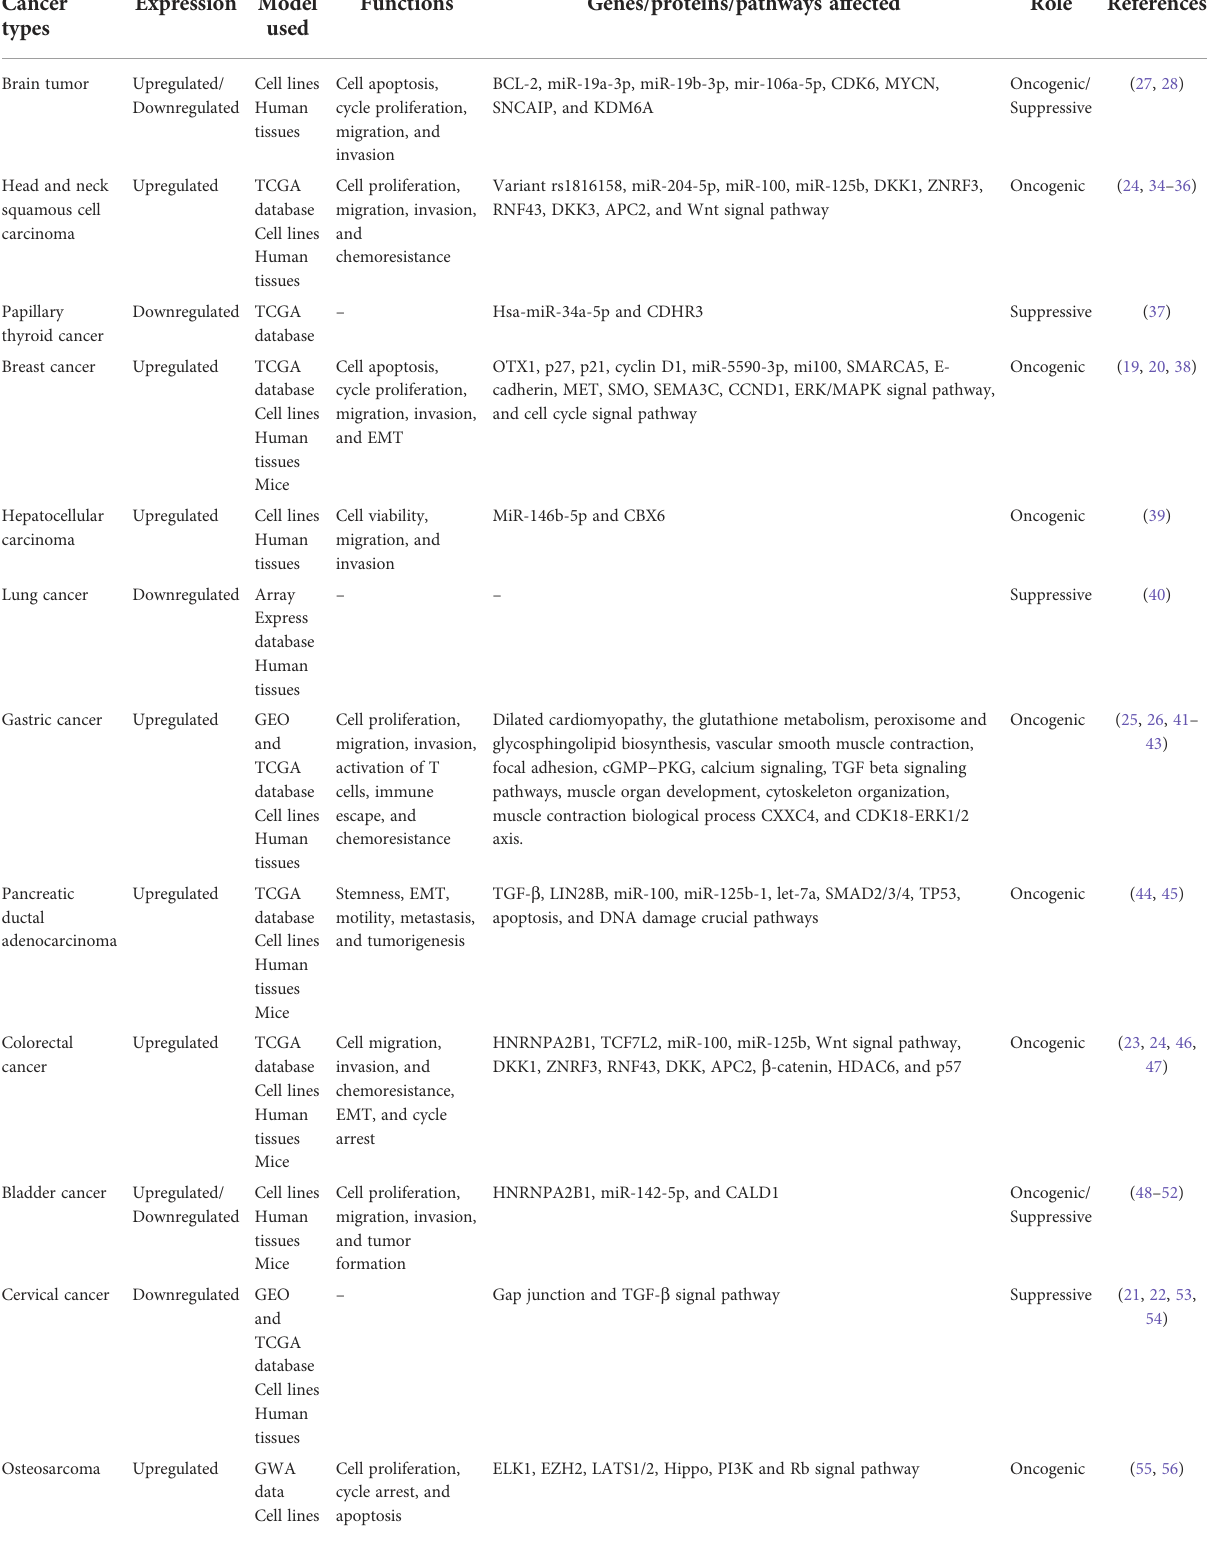
TABLE 1 Functional characterization of MIR100HG in